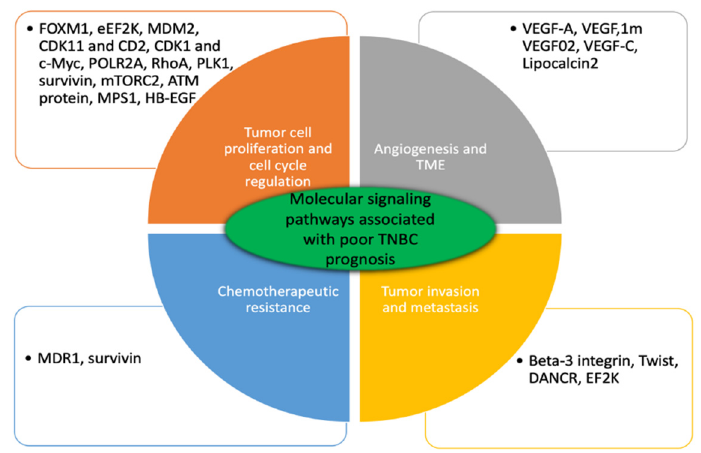
Figure 1. Major genes involved in substantial molecular pathways affiliated with poor TNBC prognosis. These genes are upregulated in patients with TNBC. Bioengineered siRNA mediated anticancer therapeutics targeted single or multiple genes knockdown their suppression and effectively improve disease progression.